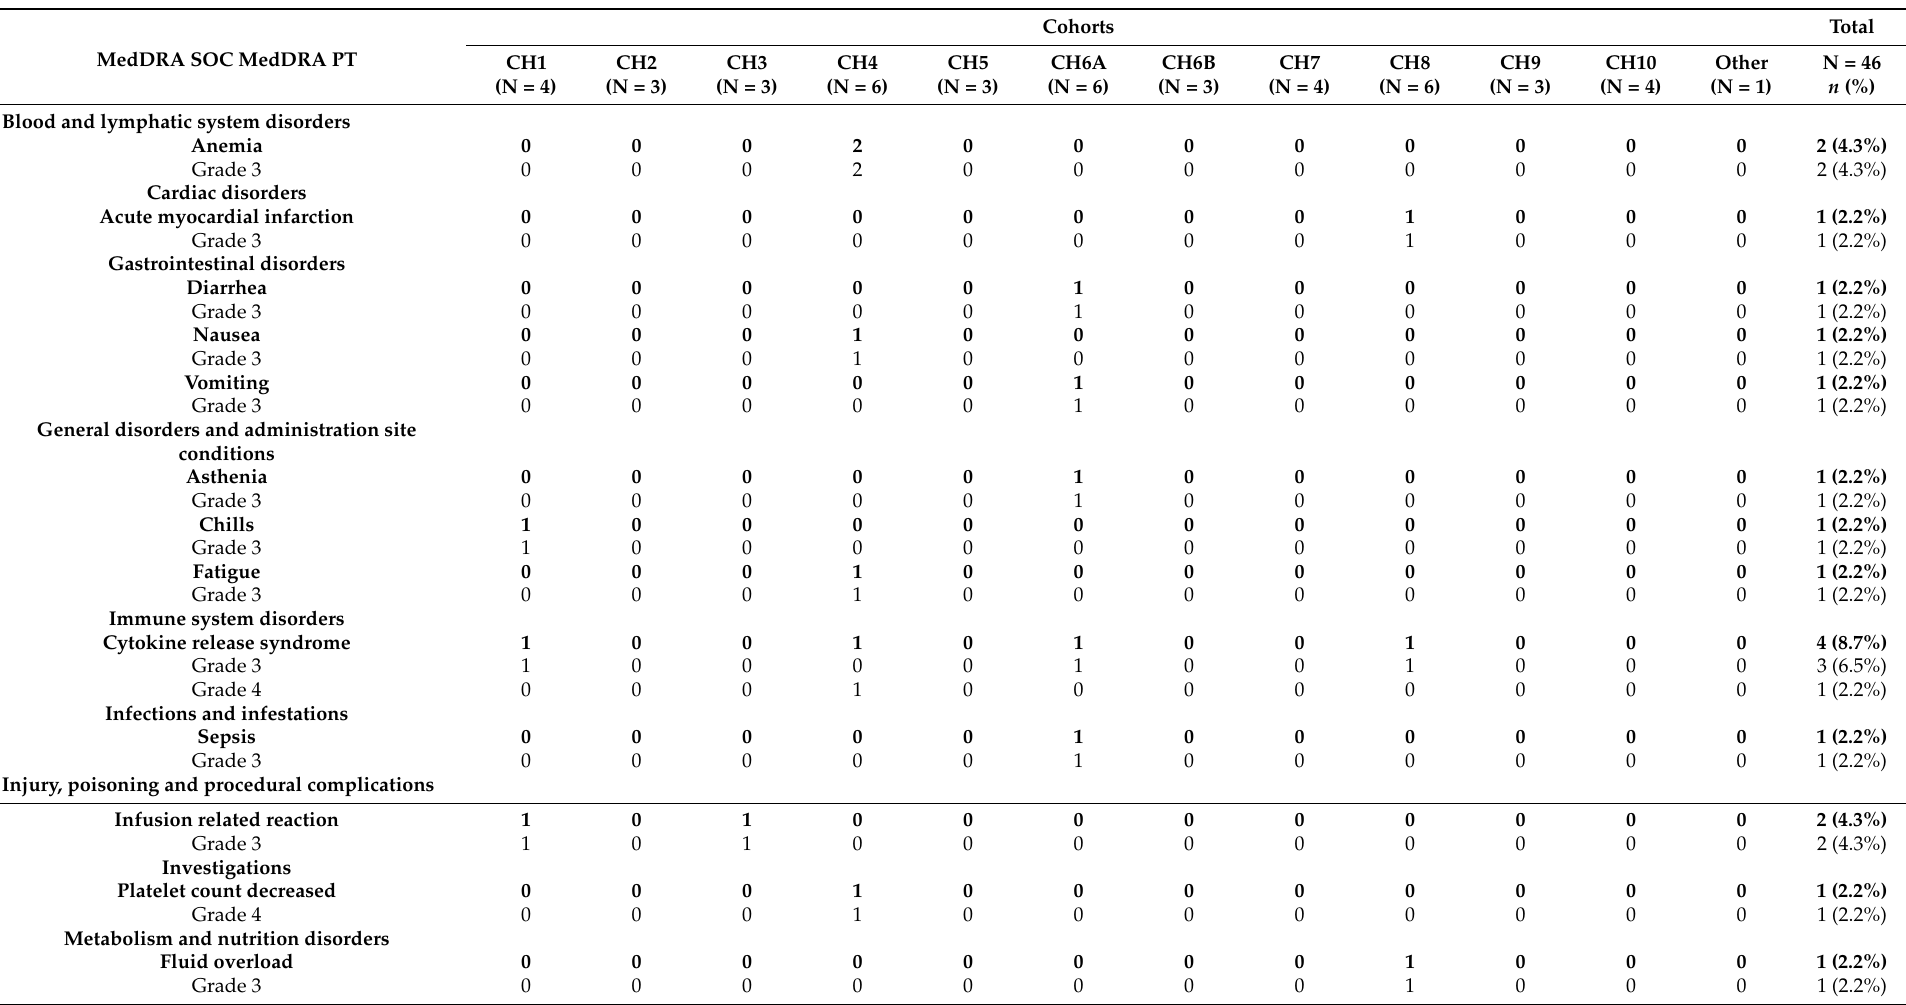
Table 2. Incidence of APVO436-related grade 3–5 AEs occurring in R/R AML/MDS patients treated on phase 1B dose escalation study